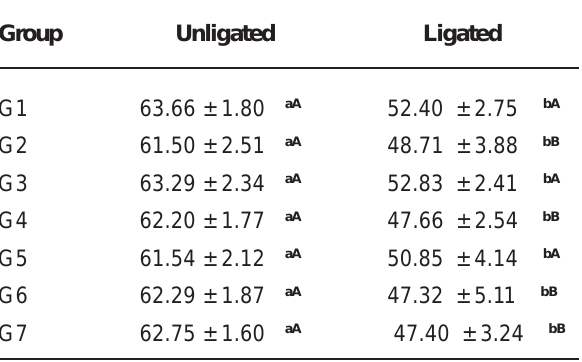
TABLE 2- Mean and standard deviation of PBS (%) in ligated and unligated